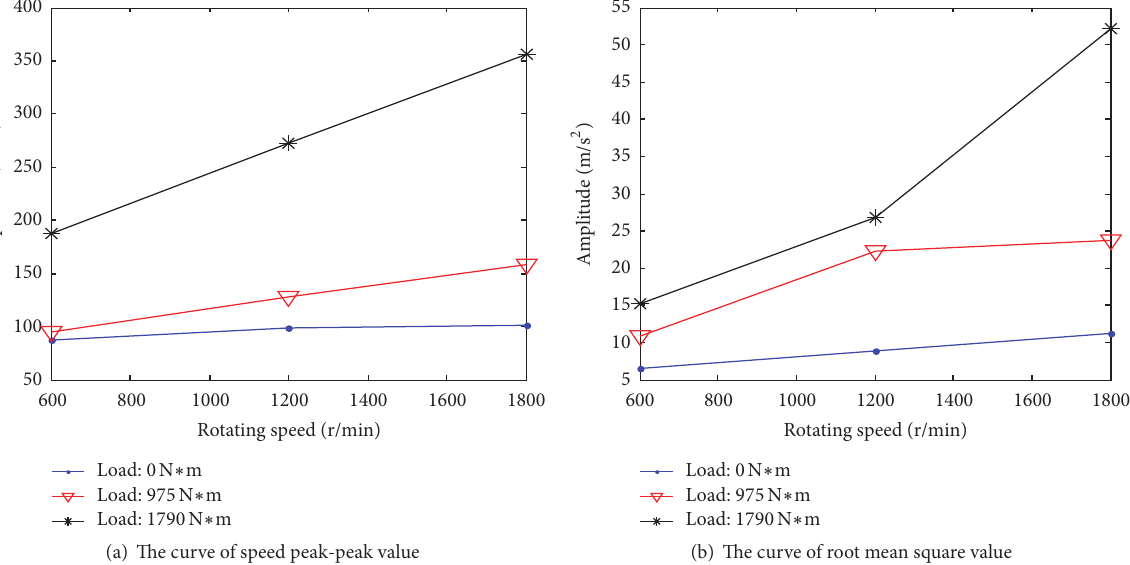
Figure 5: Broken teeth-pitting compound fault 3.